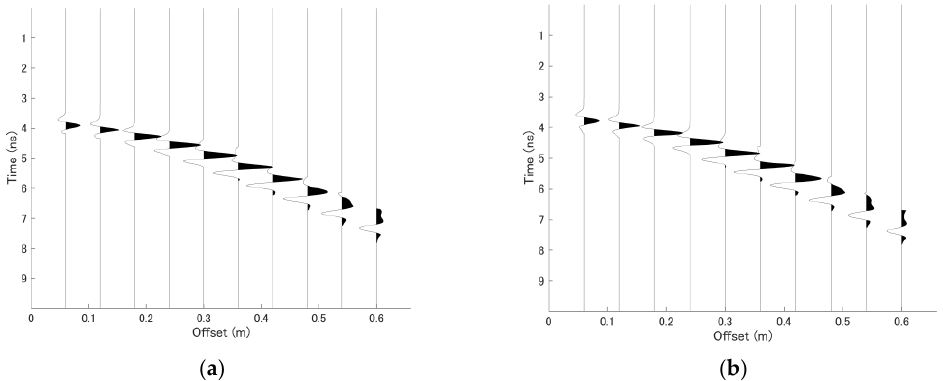
Figure 5. FDTD simulation of two single-layer CMP datasets with slight differences in velocity and thickness. ( a ) CMP dataset obtained at the reference point with a thickness of 15 cm and a velocity of 0.1 m/ns. ( b ) CMP dataset obtained at the monitoring point with thickness and velocity deviations of 1 cm and 0.03 m/ns, respectively, with respect to the reference values.